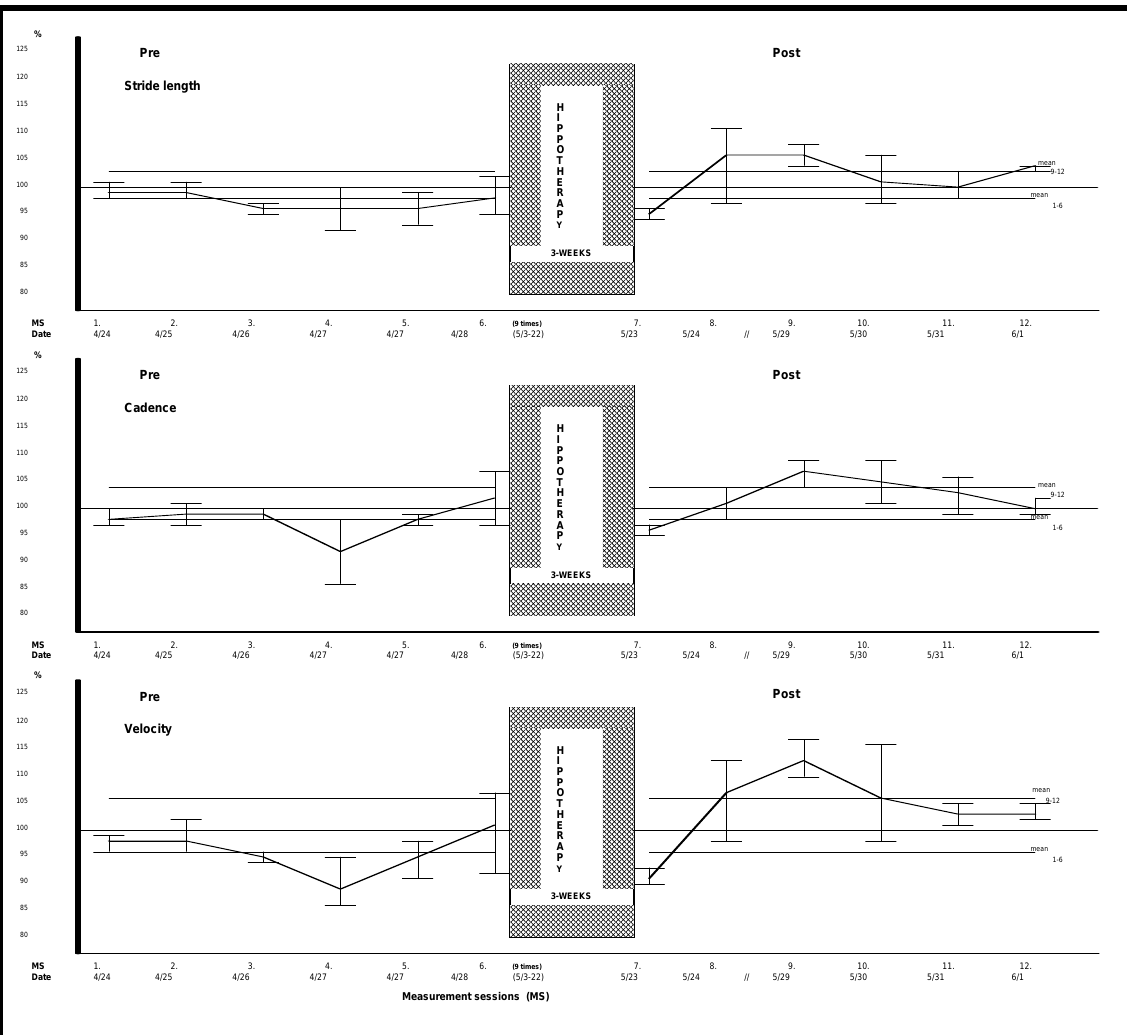
Figure 5. Helen: Gait parameters before (phase A), hippotherapy program (B), and after